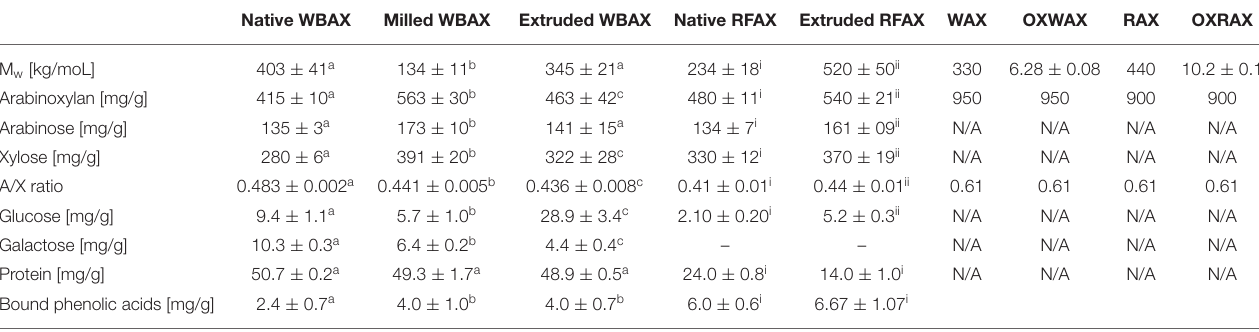
TABLE 1 | Structural features of differently processed wheat bran (WB) and rye flour (RF) arabinoxylan (AX) and wheat and rye AX standards (WAX, RAX) as well as the respective oxidized standard (OXWAX, OXRAX) *